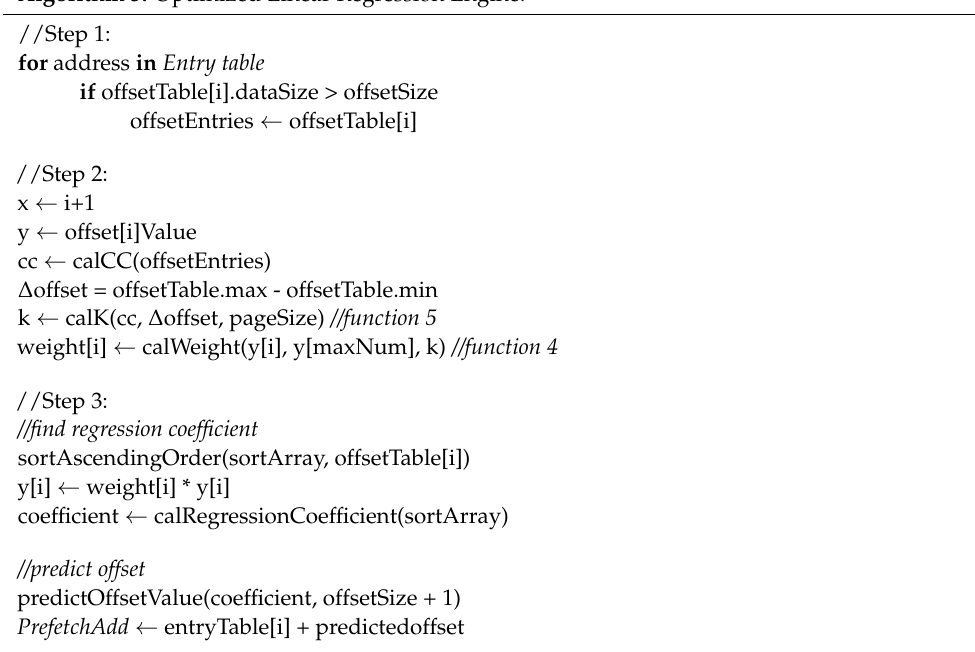
Algorithm 3: Optimized Linear Regression